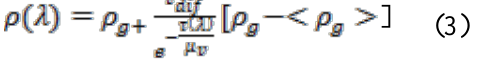
Table 1. Date and time of the two selected CHRIS images over Tor Vergata (Rome) and Bruxelles and of the nearly simultaneous AERONET stations acquisitions. The corresponding values of the solar zenith angle, the aerosol optical thickness at 550 nm (AOT@550nm) from AERONET data and from GEOS-Chem simulations, the water vapour (wv) and ozone (O3) columns, and the quality Level of AERONET data are also shown. Table 1 shows date and time of selected CHRIS images and of the corresponding atmospheric aerosol data (AOT@550nm, wv and O 3 columnar contents) from simultaneous AERONET GEOS-Chem model simulations, the solar zenith angle relative to the two CHRIS overpasses and the AERONET data quality Levels is also specified for each case studies.